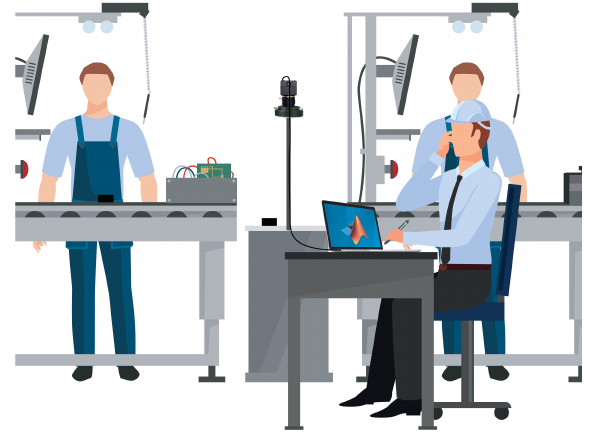
Figure 2. System setup used for project